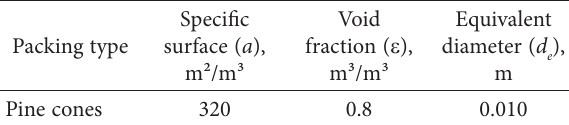
Table 2. Geometric characteristics of the pine cones packing Packing